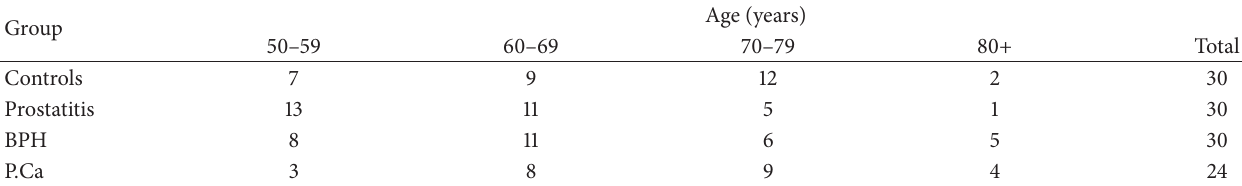
Table 1: The number of patients in each group along with their age.